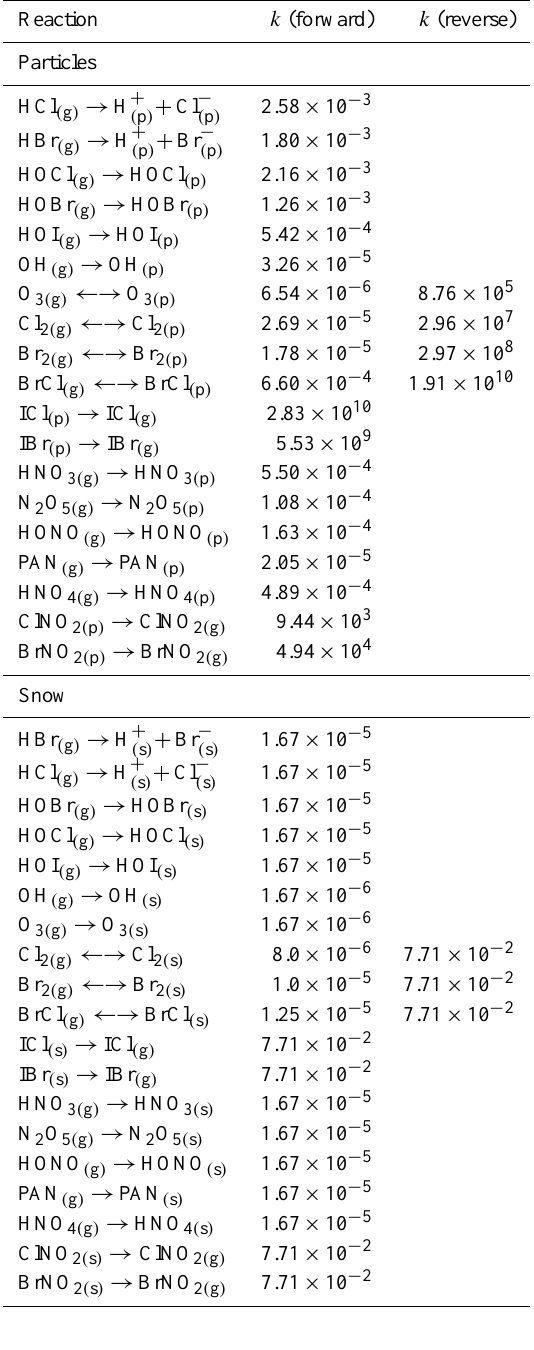
Table 3. Mass transfer reactions. All rate constants are expressed in units of s − 1